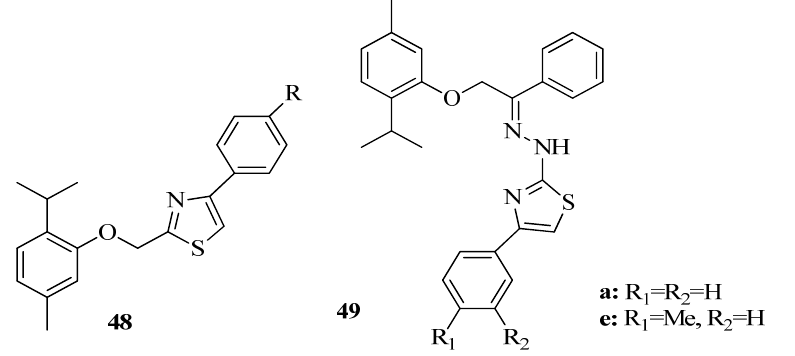
Figure 17. Structures of 4-phenyl-1,3-thiazole and 2-hydrazinyl-4-phenyl-1,3-thiazole derivatives. Biernasiuk et al. [71] synthesized fifteen novel thiazoles containing cyclohexene moiety (Figure 18) and studied their antimicrobial activity against a panel of seven Gram-positive, seven Gram-negative bacteria, and four fungal Candida species as well as 14 clinical isolates. The study revealed that compounds 50a , 50d , 50f , 50n , and 50o (Figure 18) showed a very good activity with MIC 0.015–3.91 μ g/mL against C. species, exhibiting equipotent or higher activity than nystatin used as the reference drug. The highest activity was achieved in the case of compounds 50n and 50o with MIC/MFC at 0.015–0.03 μ g/mL/0.015–0.06 μ g/mL. Thus, the presence of CH 2 COOEt and CH 3 groups